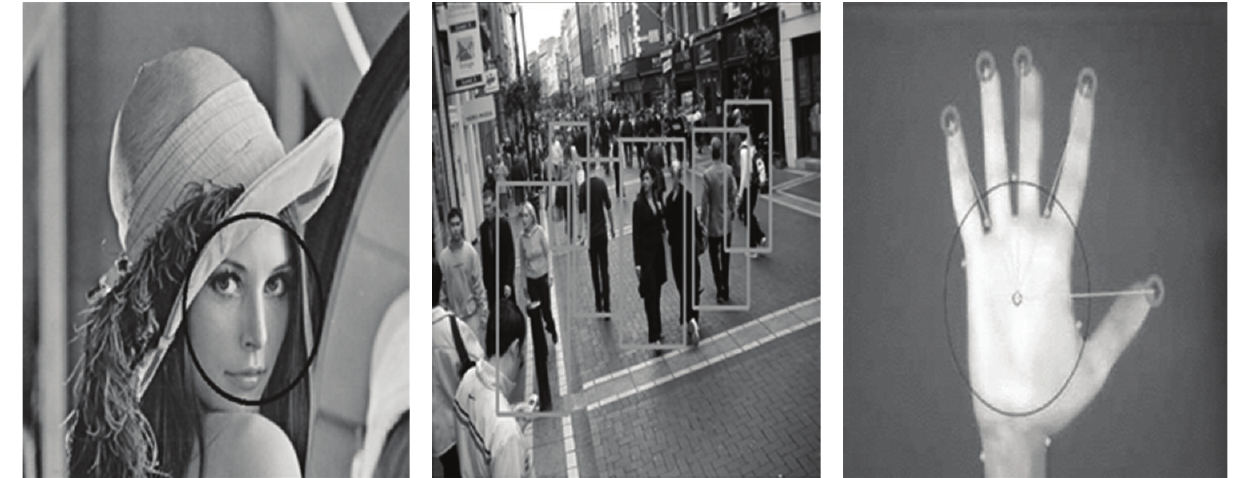
Figure 9: The results of object detection using both algorithms.